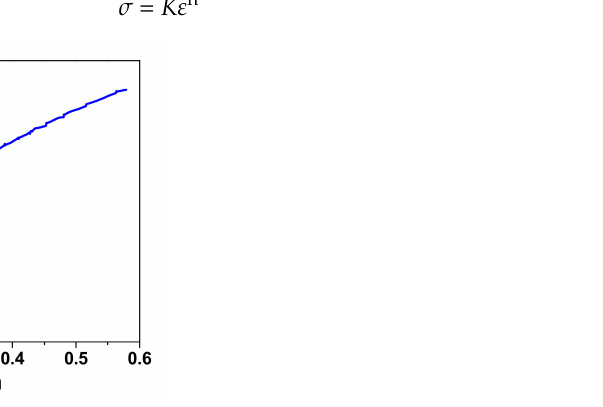
Figure 2. Comparison of true stress–strain curves of low-carbon and TWIP steels in tensile test.